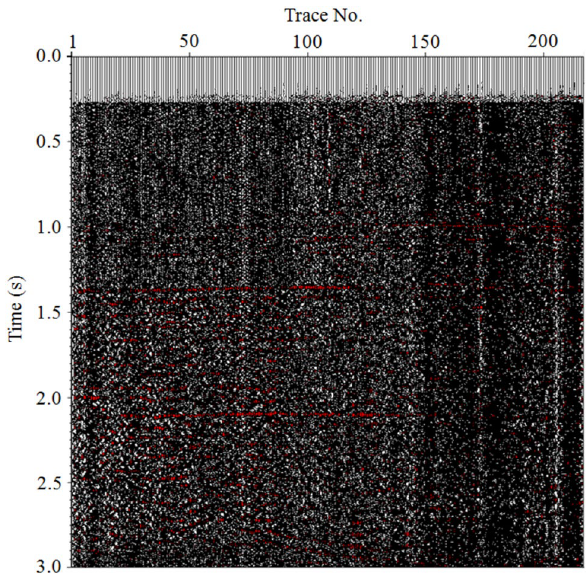
Fig. 15 Reflection signals separated from Fig. 14 using median filter- ing. Some background noise